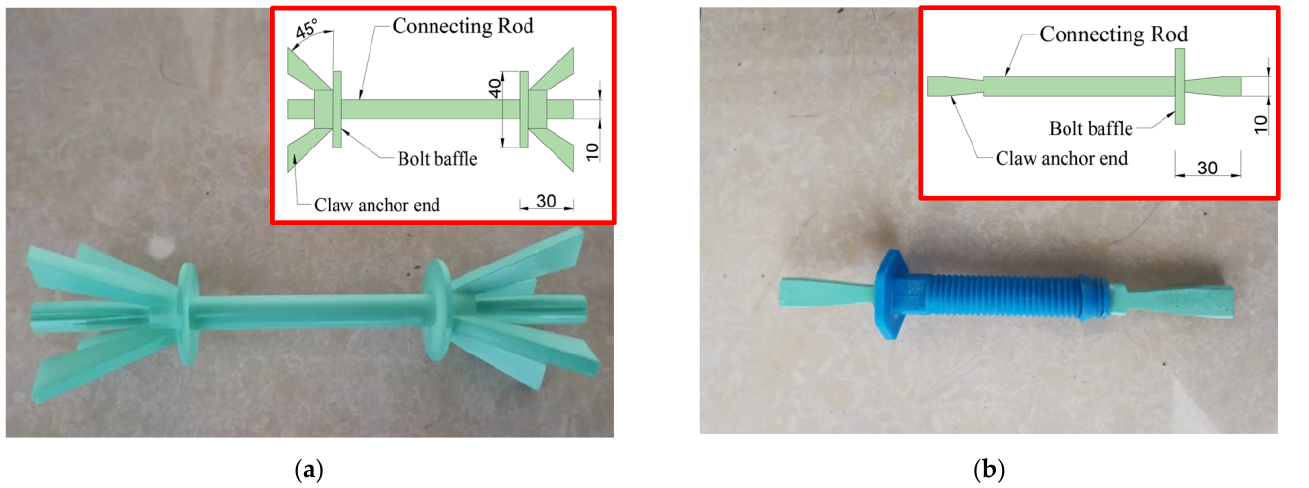
Figure 1. Physical image and dimensions of the connection parts (Unit: mm): ( a ) Claw connectors; ( b ) Rod